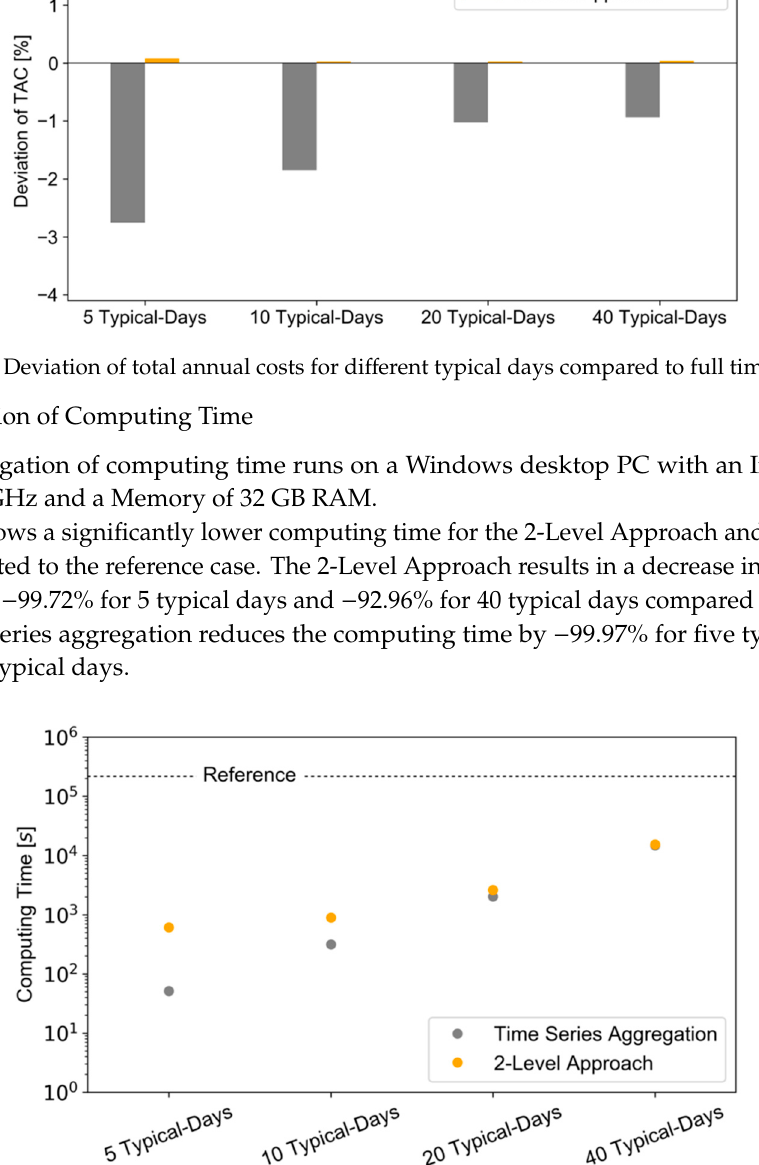
Figure 4. Deviation of total annual costs for different typical days compared to full time series.